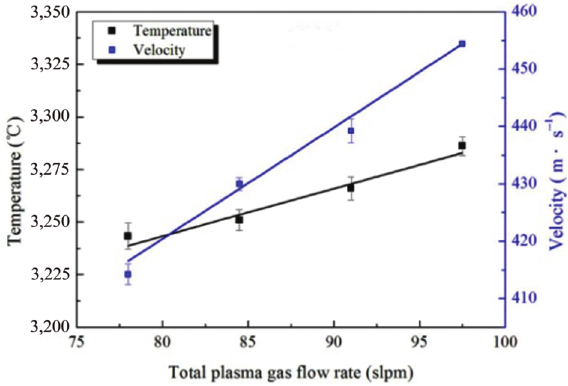
Figure 11: Effects of H 2 volume fraction on (a) particles surface temperature and flight velocity and (b) voltage at the spraying distance of 100 mm with a constant Ar gas flow rate 65 slpm, current of 420 A and power of 65 KW.